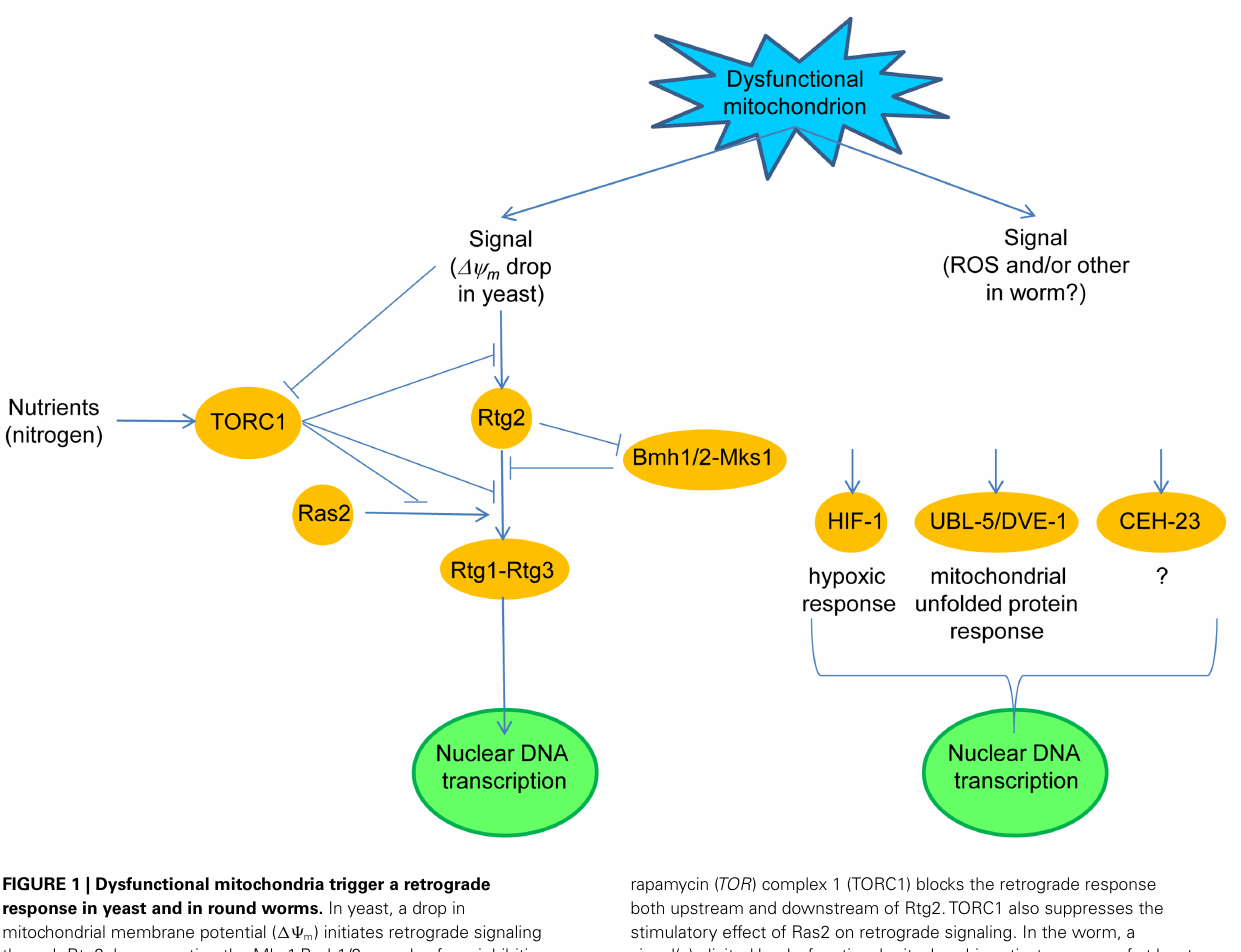
FIGURE 1 | Dysfunctional mitochondria trigger a retrograde response in yeast and in round worms. In yeast, a drop in mitochondrial membrane potential ( ΔΨ m ) initiates retrograde signaling through Rtg2, by preventing the Mks1-Bmh1/2 complex from inhibiting the partial dephosphorylation of Rtg3 in the Rtg1–Rtg3 retrograde transcription factor which is stimulated by Rtg2. Rtg1–Rtg3 translocates from the cytoplasm to the nucleus where it activates the expression of retrograde response target genes.The nutrient-responsive, target of